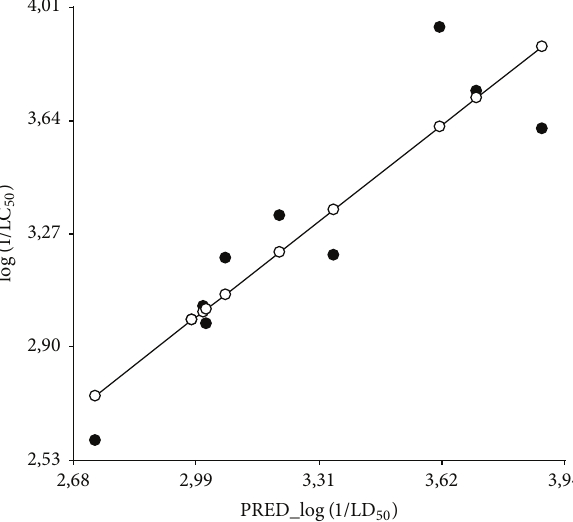
Figure 7: Multiple linear regression analysis (MLR) calculated to examine quantitative relationships between linear combinations of the dependent variable log (1/LD 50 ) and the predictor variables (structure and molecular properties). Plot of calculated versus experimental log (1/LD 50 ) of insecticidal activity of aldehyde and ketone compounds against